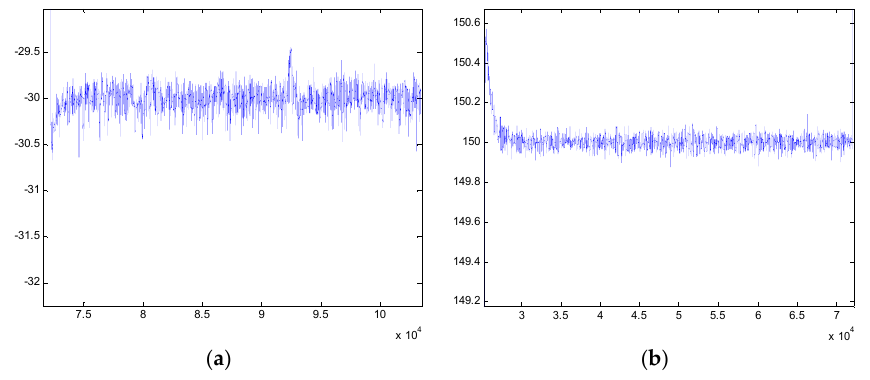
Figure 17. Stabilization results in dynamic experiments: ( a ) pitch system; ( b ) azimuth system.